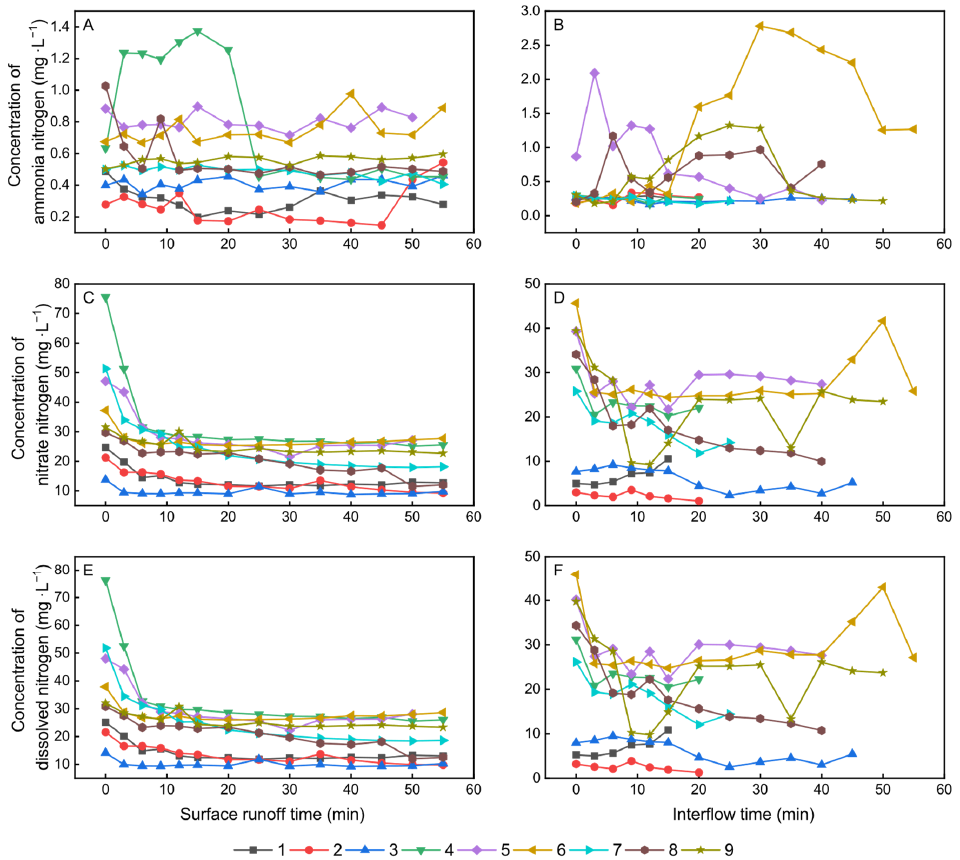
Figure 3. Changes of ammonia nitrogen (AN) ( A , B ), nitrate nitrogen (NN) ( C , D ), and dissolved nitrogen (DN) ( E , F ) concentrations over time in surface runoff ( A , C , E ) and interflow ( B , D , F ) in nine soil troughs. Table 3. Initial loss durations of surface runoff and interflow in soil troughs. Soil Trough